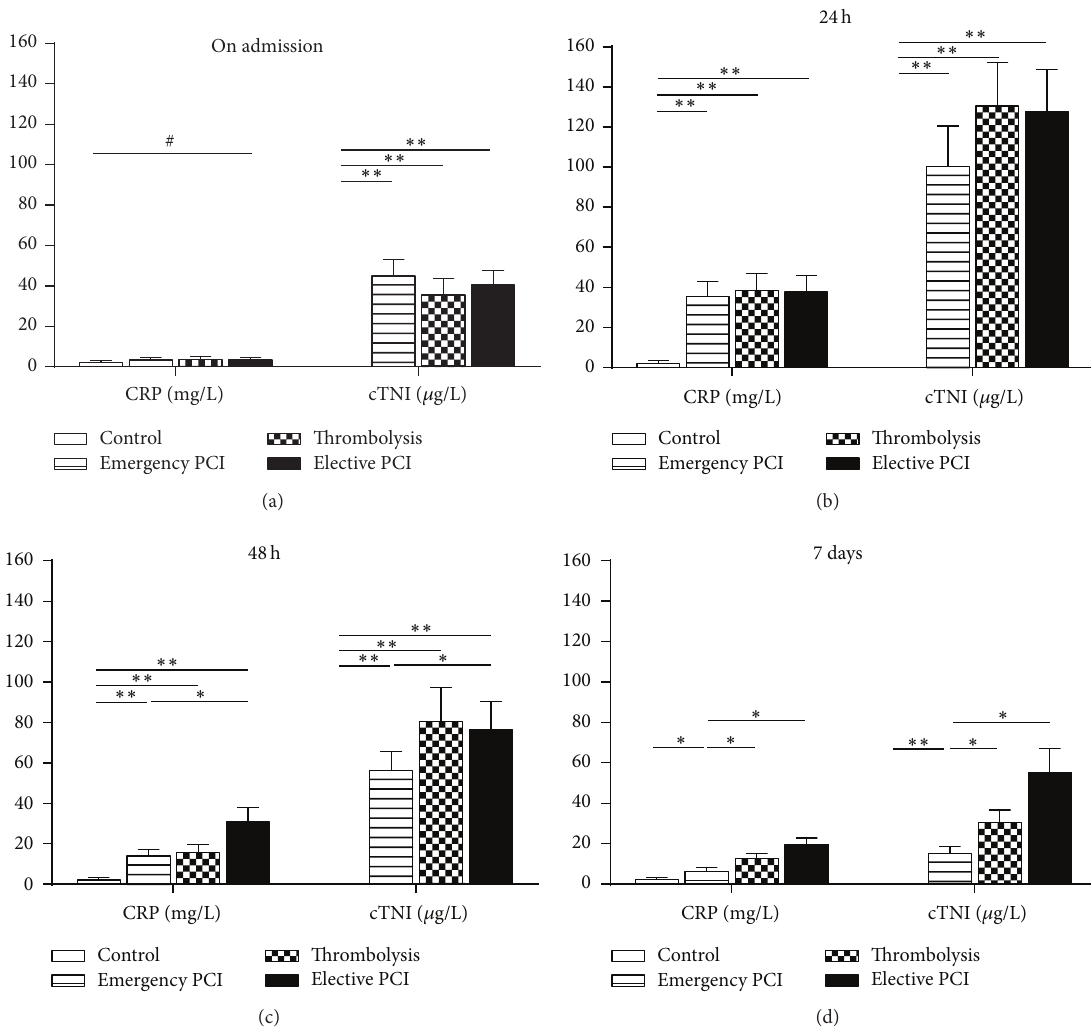
Figure 3: Plasma CRP and cTNI from STEMI patients with different reperfusion strategies. CRP and cTNI were qualified by ELISA kit in four groups (Control, Emergency PCI, Thrombolysis, and Elective PCI) at different time-points (on admission, 24 h, 48 h, and 7 days). Data are presented as mean ± SD. # 𝑃 > 0.05 , ∗ 𝑃 < 0.05 , and ∗∗ 𝑃 < 0.01